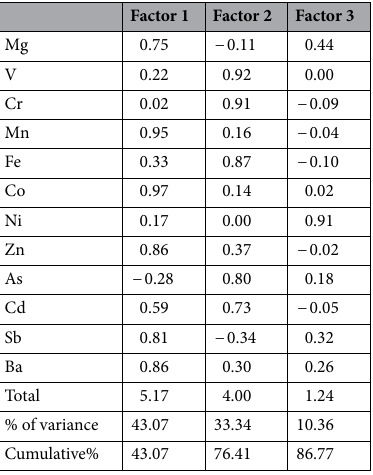
Table 3. Principal component analysis for dissolved metals.